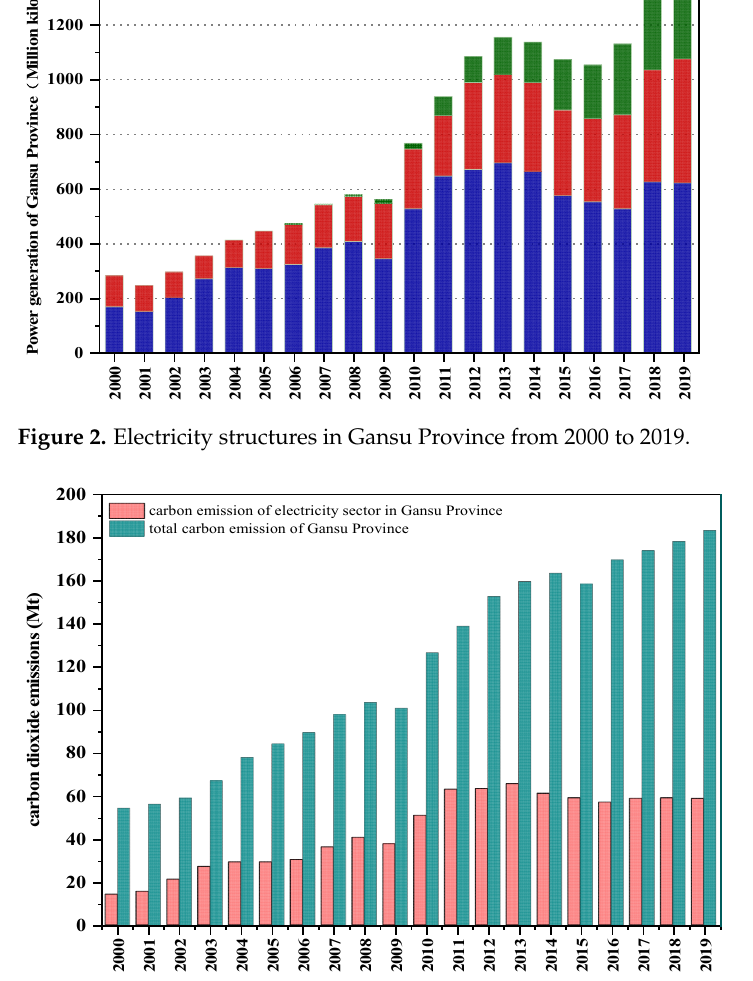
Figure 3. Total carbon emissions in Gansu Province and direct carbon emissions from the electricity sector from 2000 to 2019.